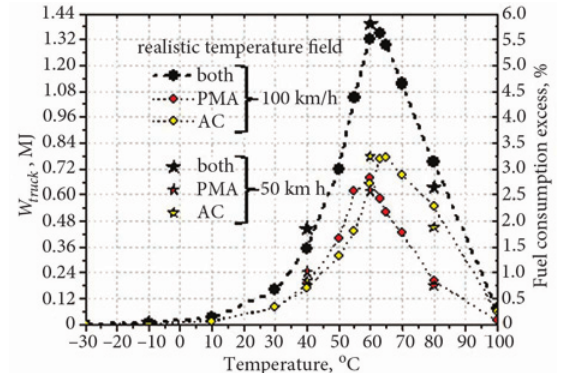
fig. 7. Evolution of dissipated energy and fuel consumption excess with temperature at 100 km/h and 50 km/h for a 40 t